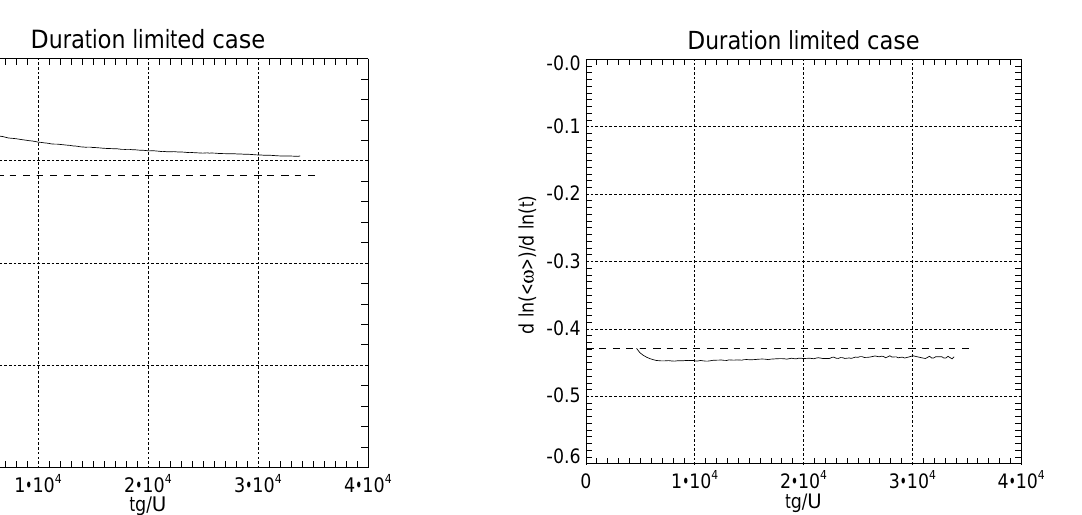
Figure 5. Mean frequency local power function index − q = dln as a func- dln t as the function of dimensionless time tg/U for the wind speed U = 10ms − 1 duration limited case (solid line). Theoretical value of self- similar exponent q = − 3 / 7 – thick horizontal dashed line.